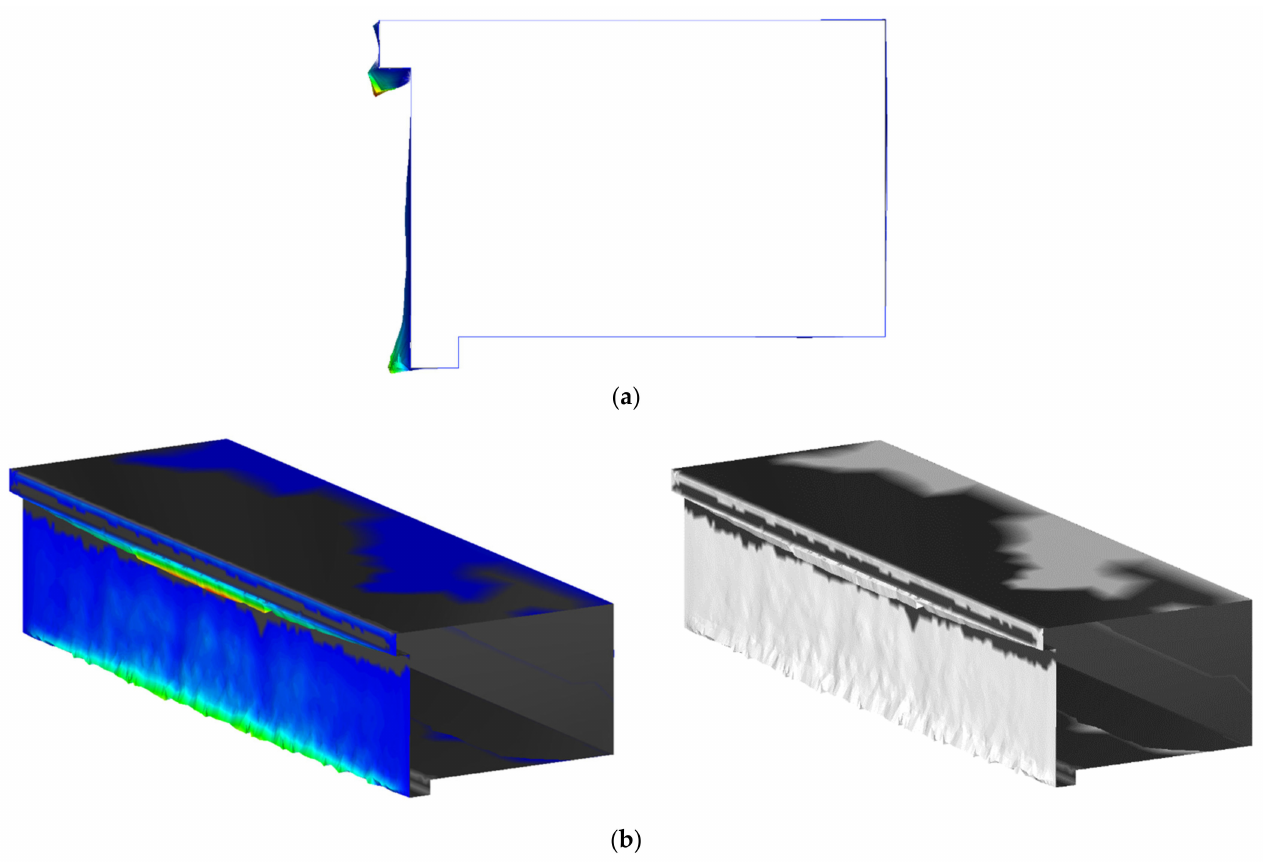
Figure 16. The ice distributions of cross beam. ( a ) Side view of ice distribution. ( b ) The 3-D view of ice